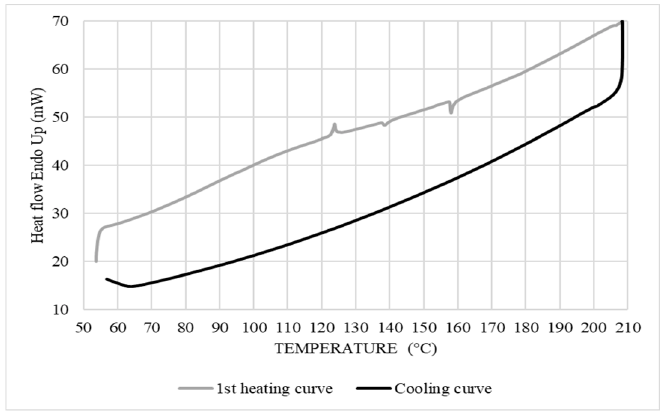
Figure 6. DSC curves of the corn starch (10 °C/min).